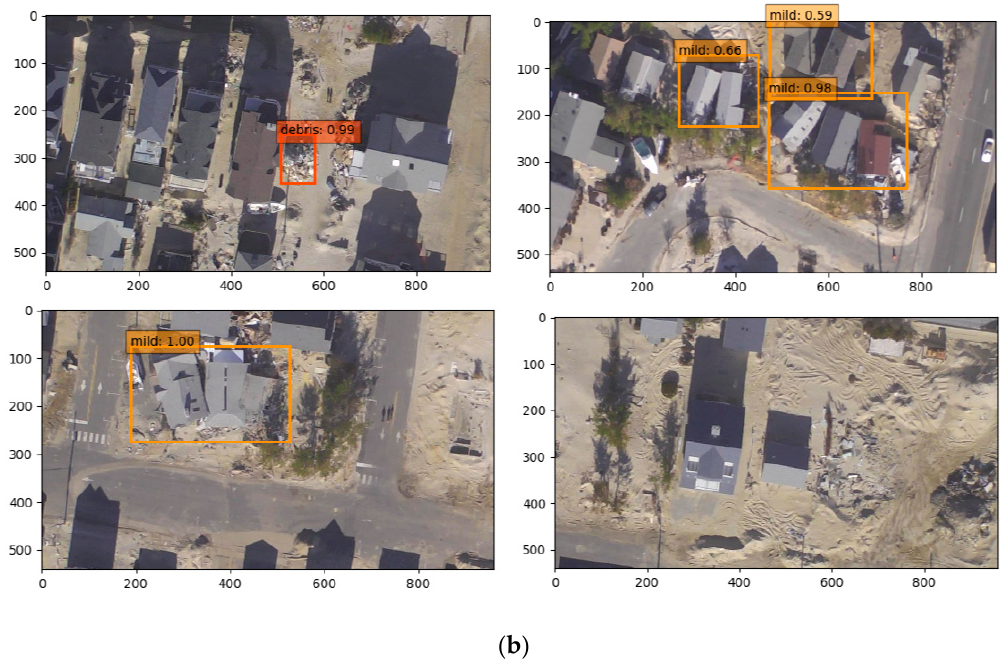
Figure 9. Object test results for both models; ( a ) is the result of the data augmentation method; ( b ) is the result of the original dataset method.